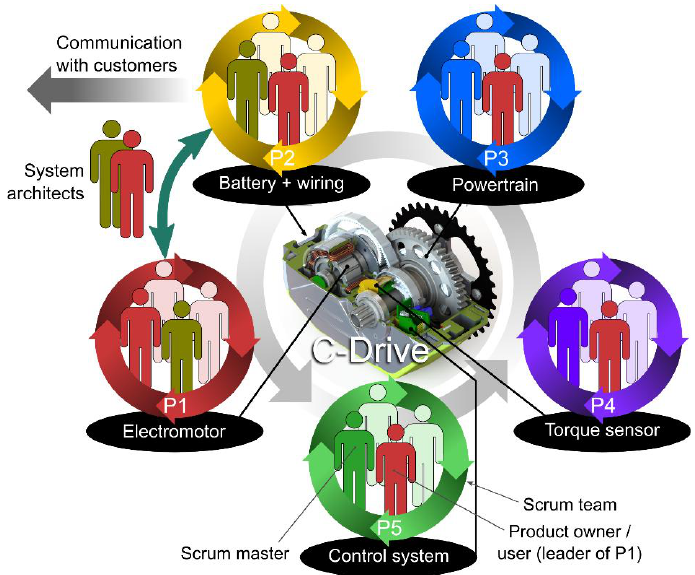
Figure 1. Composition of the sub-teams for various powertrain